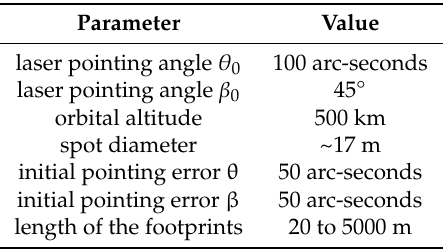
Table 3. Experimental parameters.